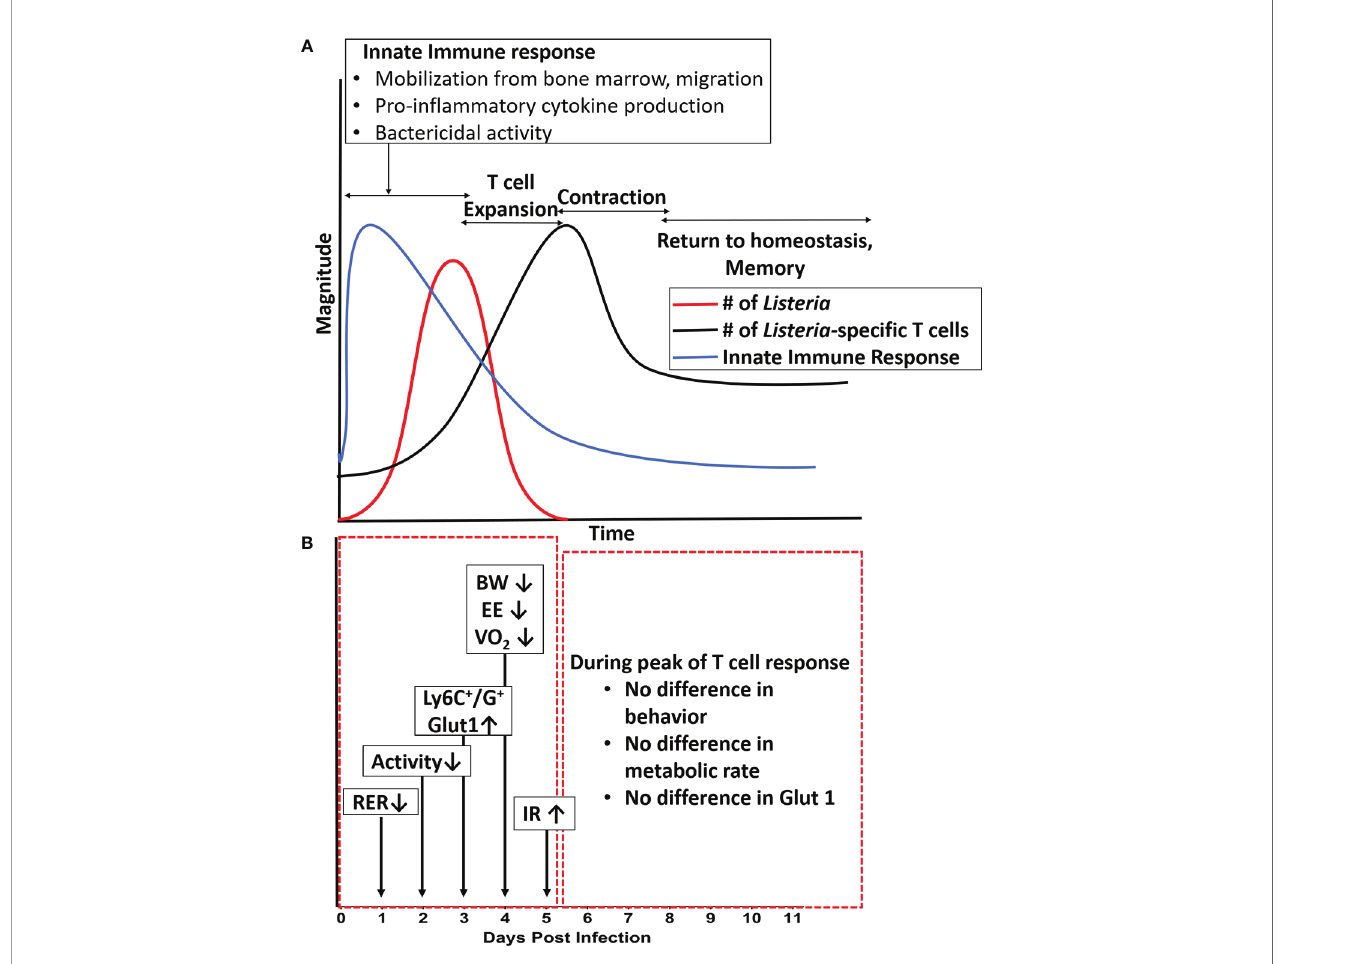
FIGURE 7 | Summary of metabolic changes against the backdrop of immune response over the course of a primary infection. (A) Illustration of the magnitude of bacterial infection, innate response, and adaptive (T cell) response over time. (B) Summary of changes in systemic and cellular metabolic phenotype over time. Long arrows denote days at which most signi fi cant differences were observed in speci fi c readout vs. uninfected control. Shorter arrows indicate direction of change in a speci fi c readout. BW, body weight; EE, energy expenditure; HOMA-IR, Homeostatic Model of Insulin Resistance; RER, Respiratory Exchange Ratio; VO 2 , metabolic